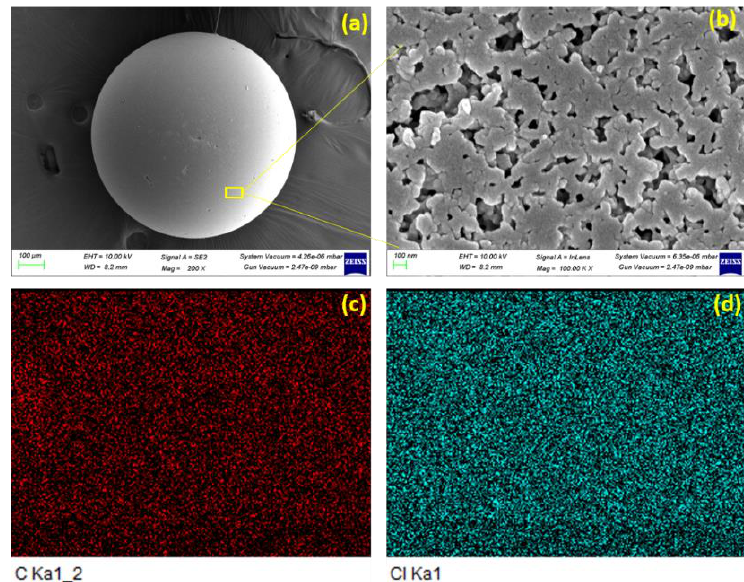
Figure 14. ( a ) FE-SEM image of chloromethylated polystyrene bead, ( b ) high-resolution FE-SEM image of chloromethylated polystyrene bead, ( c ) elemental mapping of carbon in chloromethylated polystyrene bead and ( d ) elemental mapping of chlorine in chloromethylated polystyrene bead.